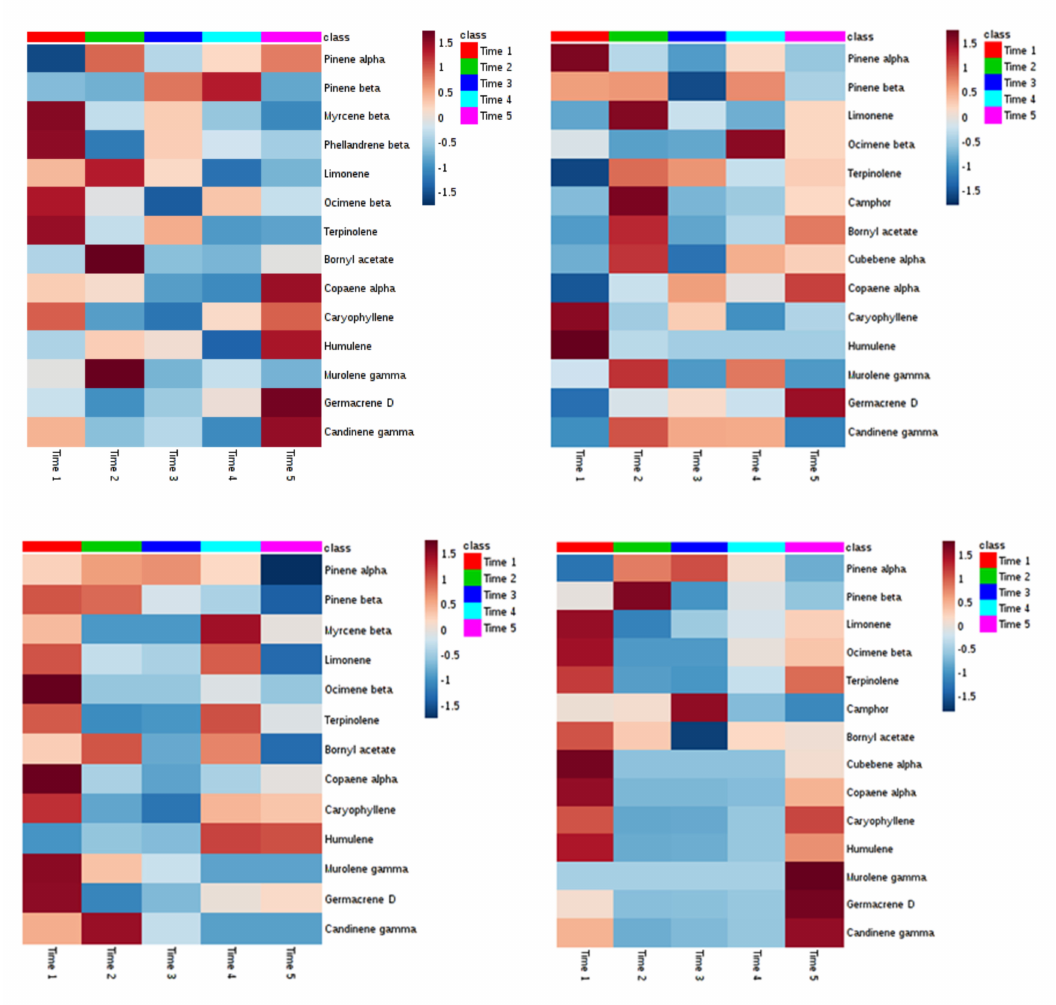
Figure 16. Heatmap synopsis of the changes in the emission of volatile terpenoids from Calabria pine needles (y axis) at five sampling points (x axis) during the trophic season of the pine processionary moth caterpillars. Brownish colors indicate increase, bluish colors indicate decrease. Upper left, infested plants in Bova; upper right, not infested plants in Bova; lower left, infested plants in Canolo; lower right, not infested plants in